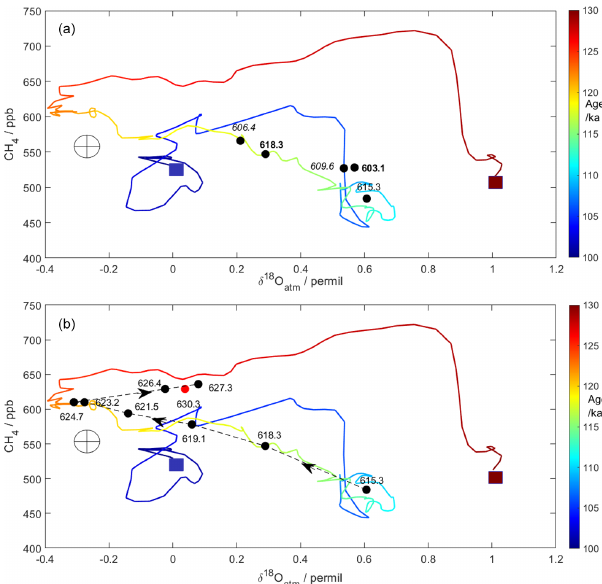
Figure 9. Cross plots of CH 4 (Köhler et al., 2017) and δ 18 O atm (Extier et al., 2018) reference data for the period 100–130ka, along with Skytrain Ice Rise data from (a) 603–618m depth and (b) 615– 628m (black dots) and 630.3m (red dot). The combined uncer- tainty (used to decide whether a match between the Skytrain and reference data is acceptable) is shown by the grey ellipse/cross. The start (130ka) and end (100ka) of the reference curve are marked by red and blue squares. Skytrain data points are marked with depths; in panel (a) the ones we later judge as being in disturbed ice are marked with italics, while the ones we consider well dated are in bold. In panel (b) , the black dots are joined by a dashed line, with arrows pointing in order of increasing depth. An alternative visual- isation of this figure is provided in Fig.